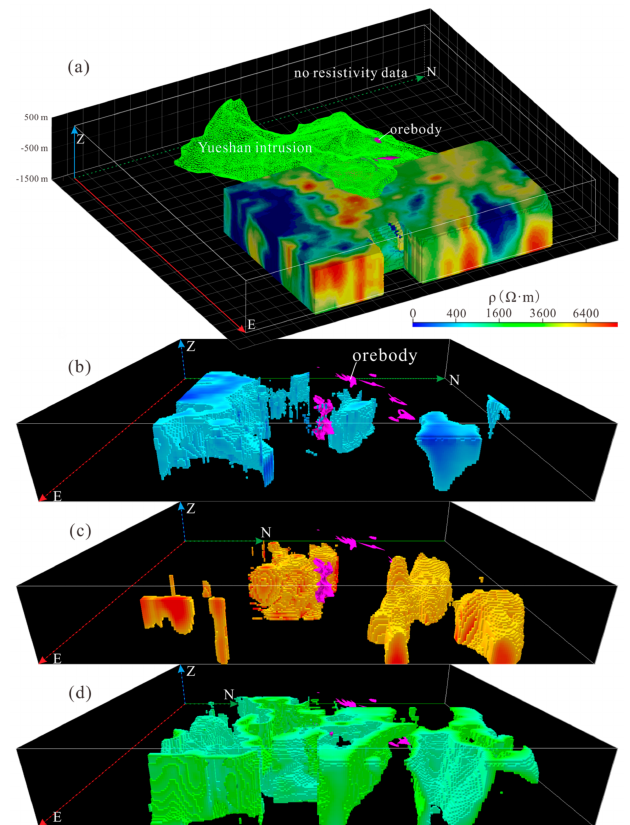
Figure 8. ( a ) 3D resistivity field and its location in study area, showing the spatial association of orebodies with different resistivity space; ( b ) ρ is less than 500 Ω · m; ( c ) ρ is greater than 7000 Ω · m; and ( d ) ρ is between 500 Ω · m and 2500 Ω ·